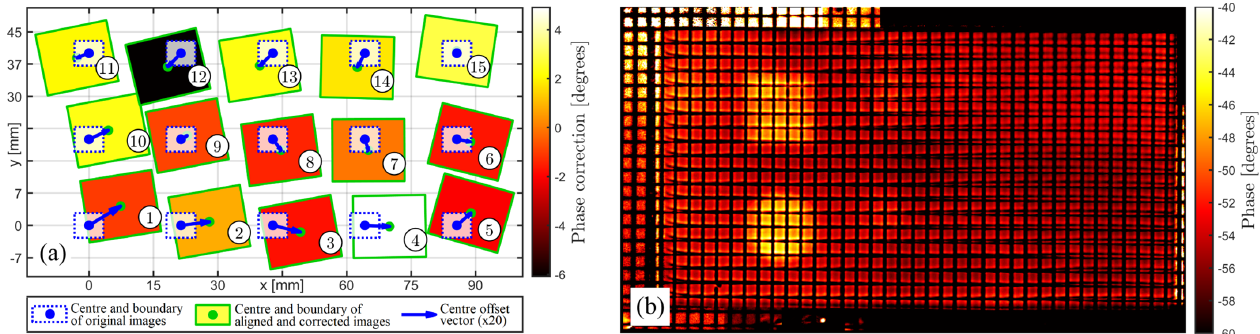
Figure 12. ( a ) Schematic illustration of similarity transformations and pixel intensity corrections computed through the proposed method for the set of images relative to the sample with the grid. ( b ) Resulting composite mosaic thermographic image.